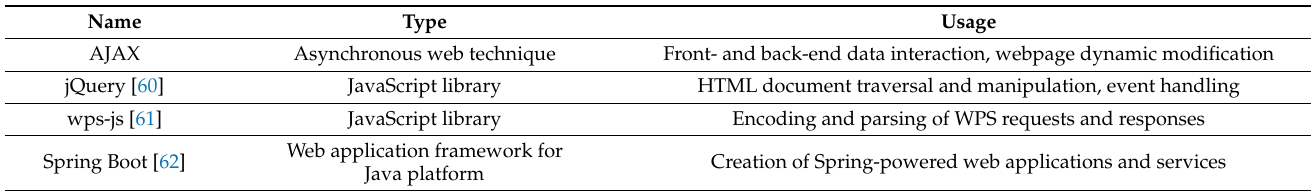
Table 1. Technology